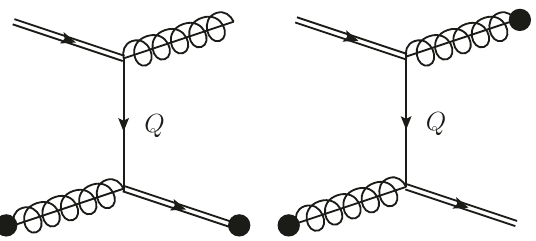
Figure 3 . Diagrammatic representation of the conversion and gain terms in soft quark exchange processes. The graphical notation is the same as in (cid:12)gure 2 and the intermediate quark is soft (single line). The diagram on the left is a conversion term, entering in ( f q the one on the right is a gain